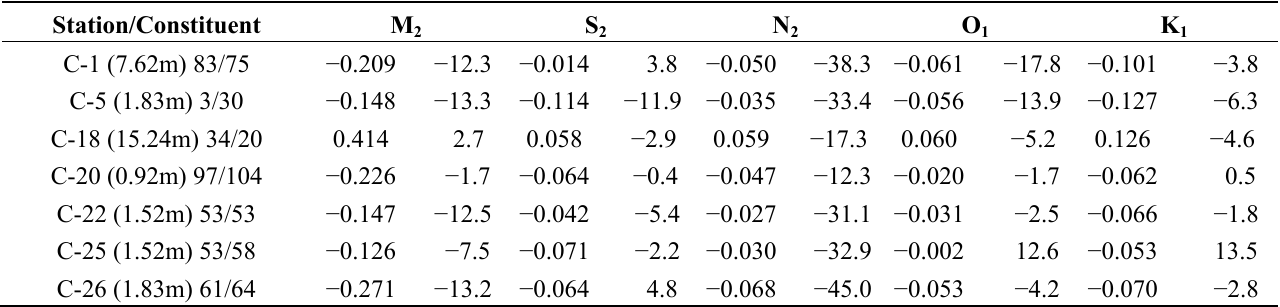
Table 6. Harmonic Analysis of 19-month tidal simulation principal current direction current comparison to NOS accepted tidal current constituents. Accepted constituent values of amplitudes (m/s) and phase (degrees) minus model predictions. Note negative amplitude differences denote an under prediction of tidal current constituent amplitudes, while positive phases denote a lag in tidal current constituent propagation. Along with station id measurement, depths are given in parenthesis with observed/model principal component directions given following the depth